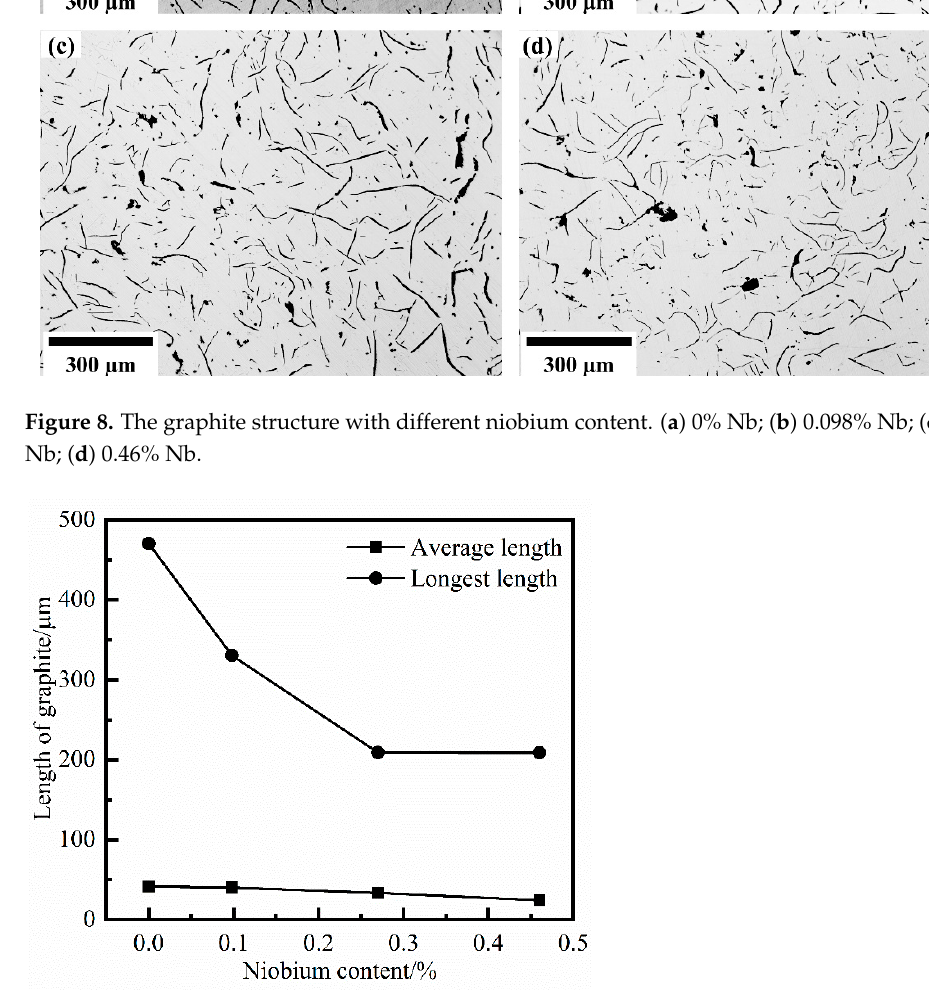
Figure 9. The statistics on the length of graphite with different niobium content.